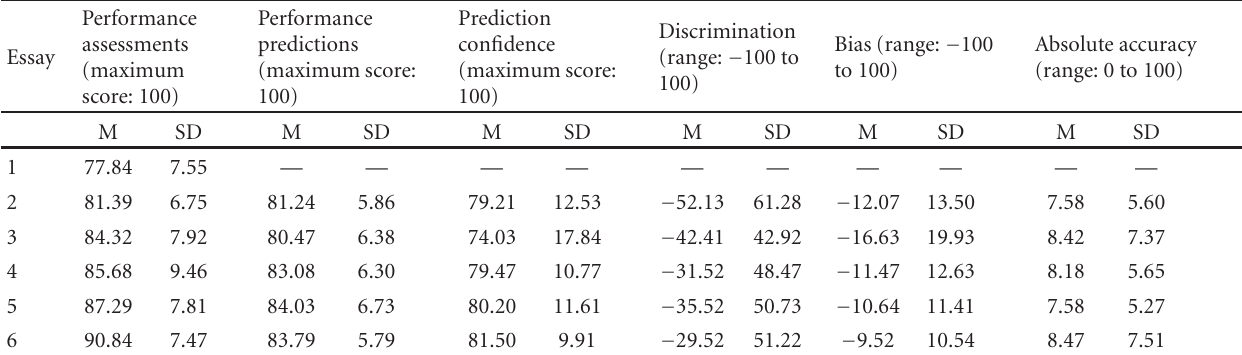
Table 4: Descriptive statistics for performance assessments, students’ performance predictions, prediction confidence, bias, discrimination, and absolute